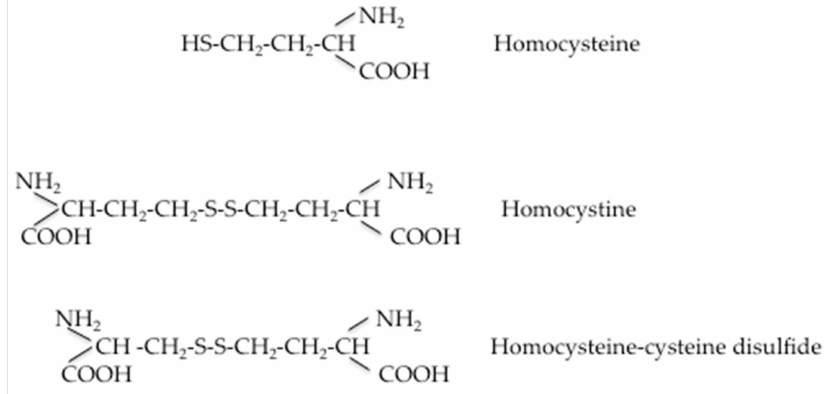
Figure 2. Forms of Hcy present in human